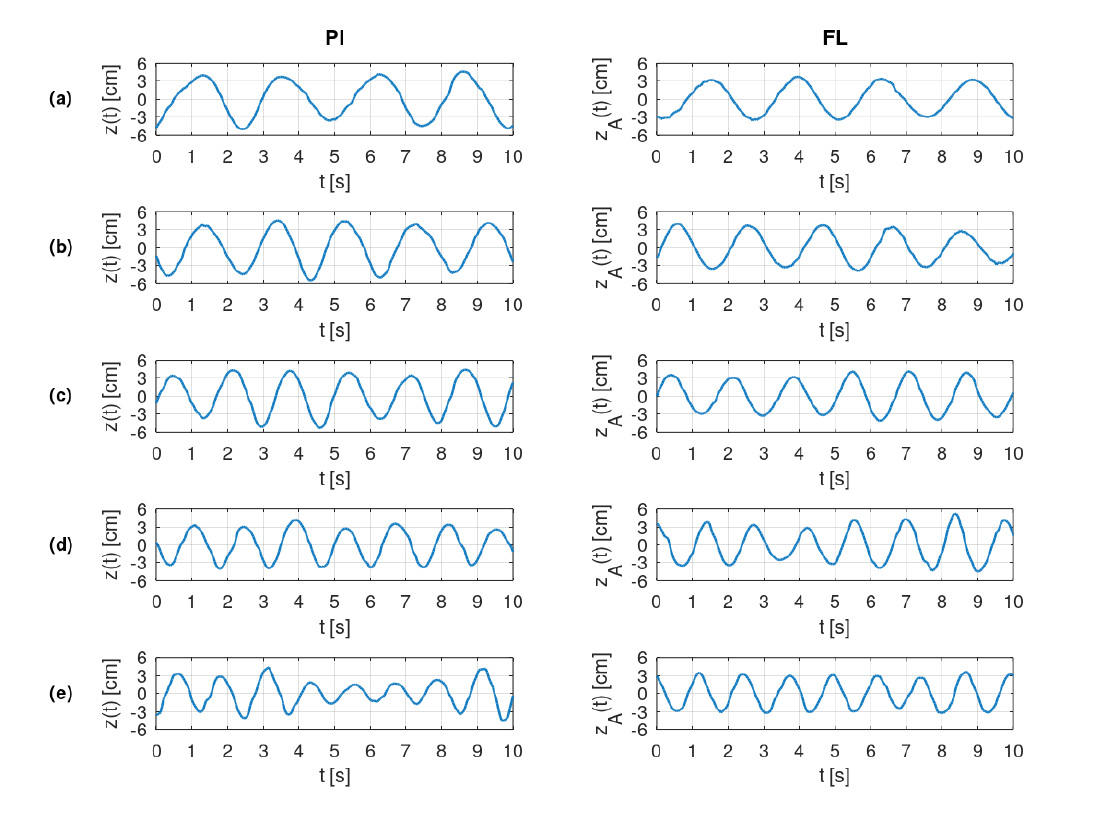
Figure 13. The profiles of the waves generated under the PI controllers and FL controller with desired wave amplitude of 3.5 cm and frequencies of: ( a ) 0.4 Hz, ( b ) 0.5 Hz, ( c ) 0.6 Hz, ( d ) 0.7 Hz, ( e ) 0.8 Hz.